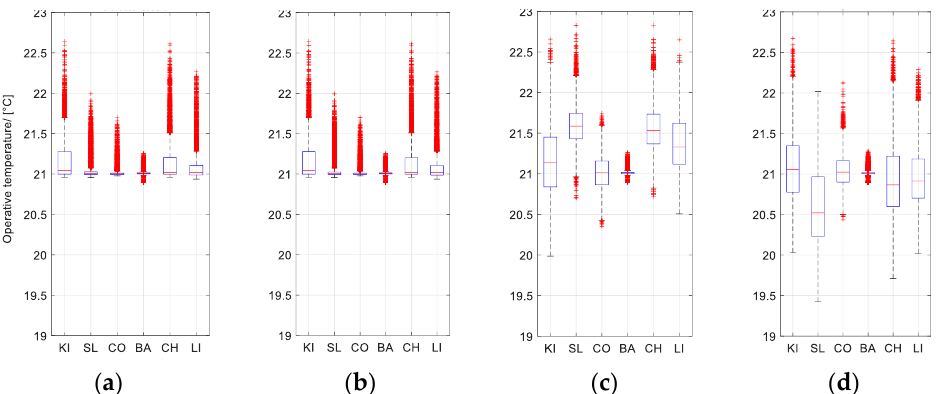
Figure 17. Box plot of operative temperatures (hourly average) during the heating season for ( a ) the reference (with room-wise electric radiators) and for the three presented heating concepts, ( b ) split HP with room-wise electric radiators ( c ) supply air heat pump, and ( d ) supply air heat pump with recirculation.